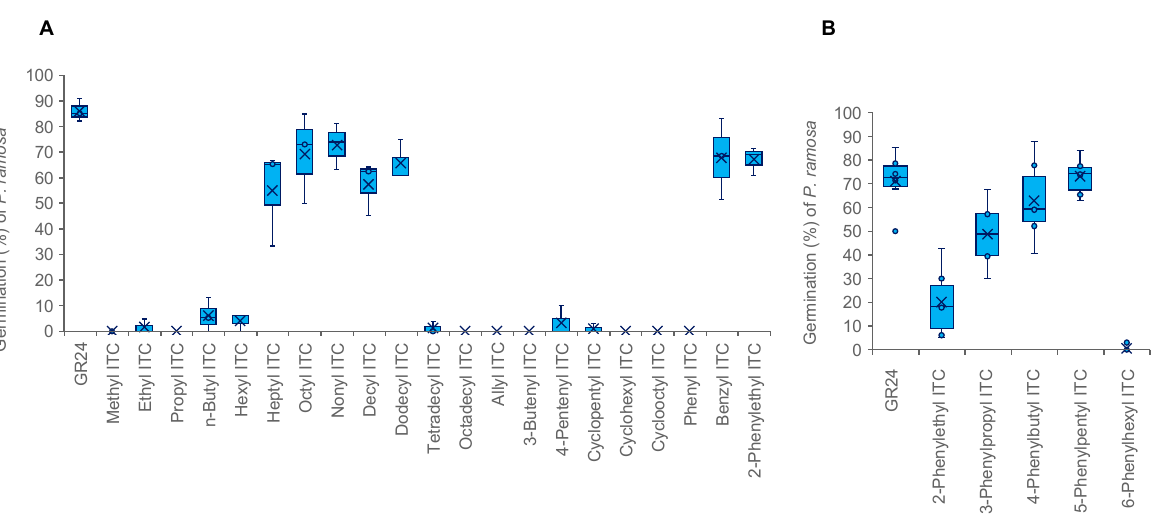
Figure 1. Chemical structures of isothiocyanates used in this study. ( A ) Commercially available products. ( B ) Synthesized in this study.